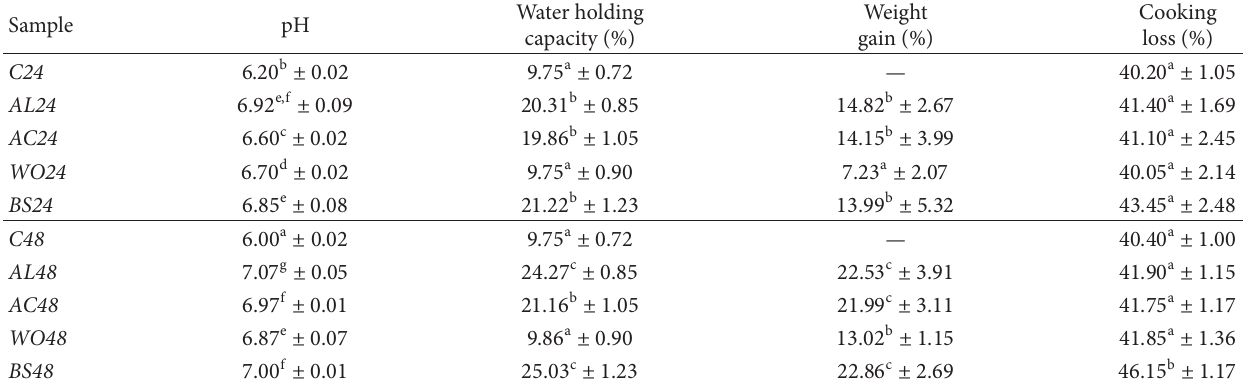
Table 3: Changes of the pH, water holding capacity, weight gain, and cooking loss of marinated sheep. Water holding Sample pH capacity (%)